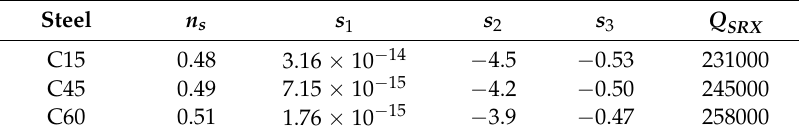
Table 7. Model coefficients for static